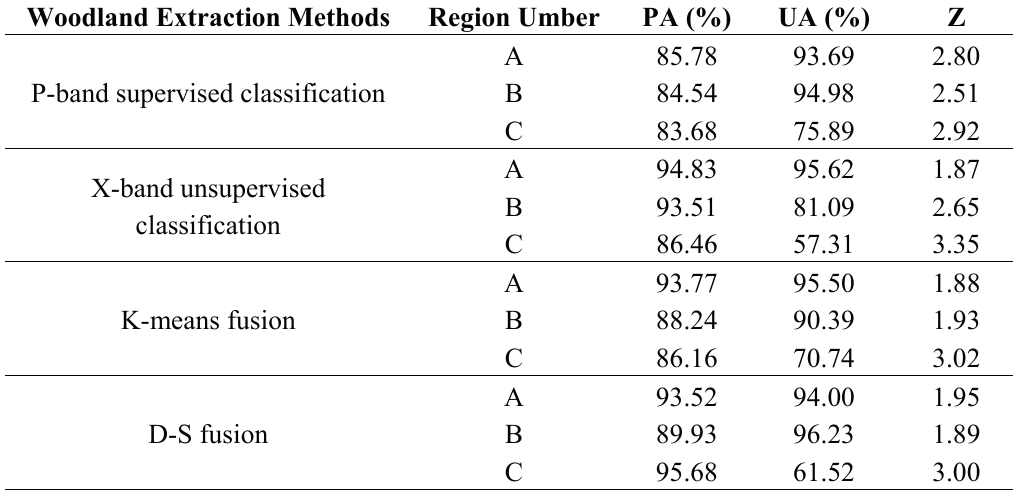
Table 11. The accuracy evaluation of the woodland extraction results with the different